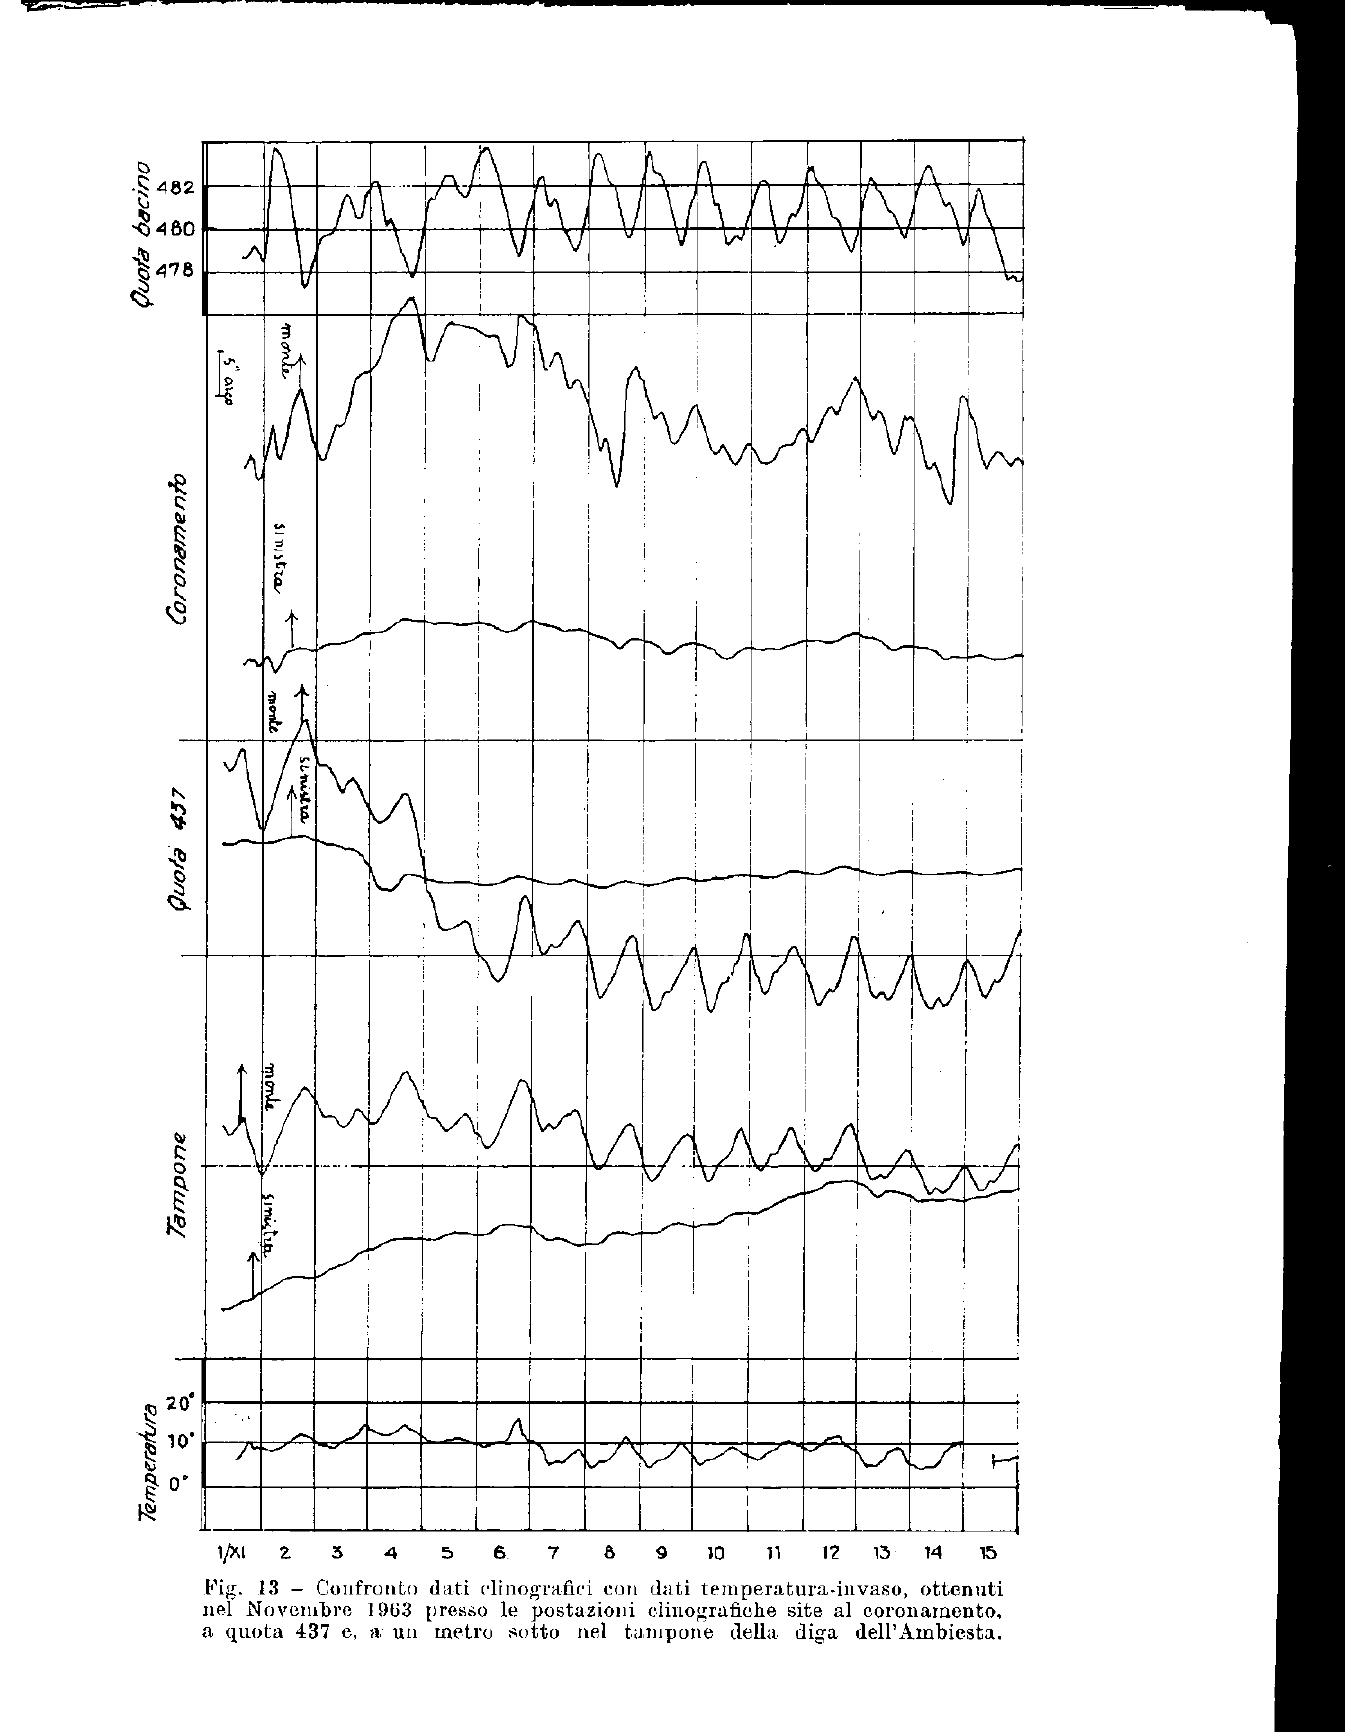
Fig. 13 - Confronto dati clinografici con dati temperatura-invaso, ottenuti nel Novembre 1963 presso le postazioni clinograflche site al coronamento, a quota 437 e, a un metro sotto nel tampone della diga